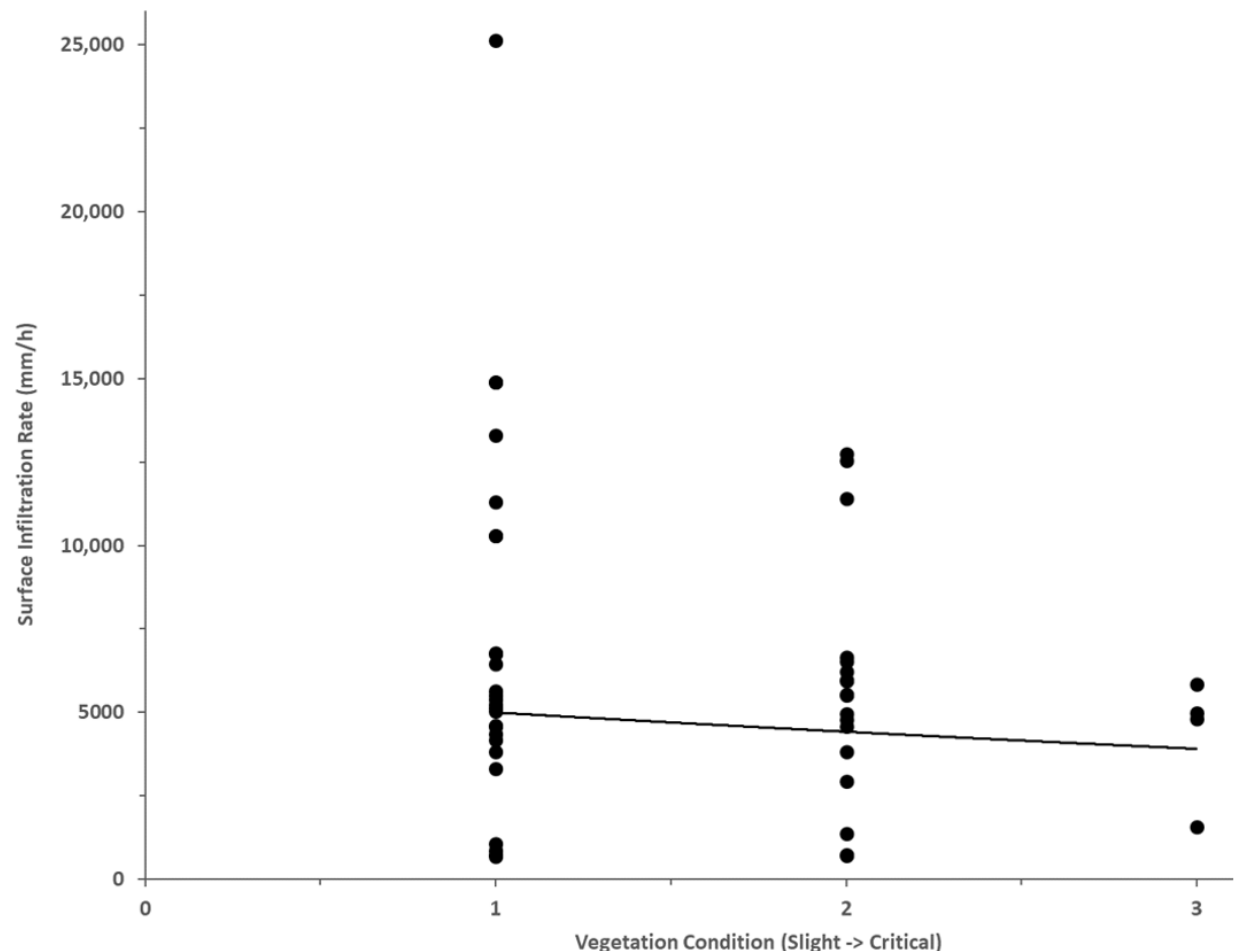
Figure 7. Infiltration rate versus vegetation cover.